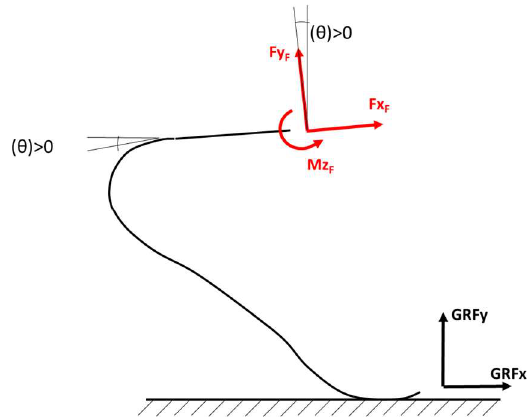
Figure 7. Absolute orientation of the iRPF used for the reconstruction of loads applied to the iRPF from the ground in the Global Reference System.